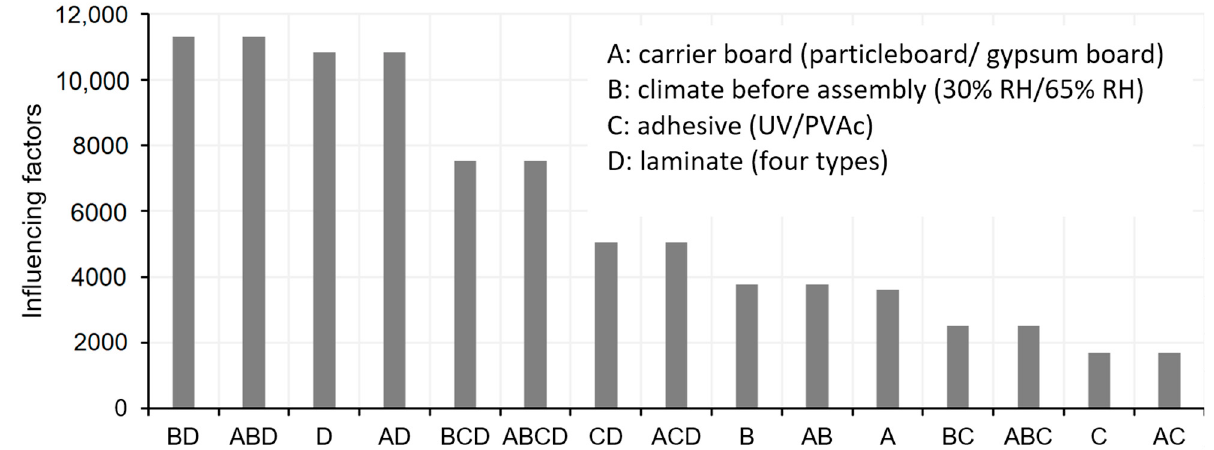
Figure 7. Sum of squares of the influencing factors (response) on the length of cracking.